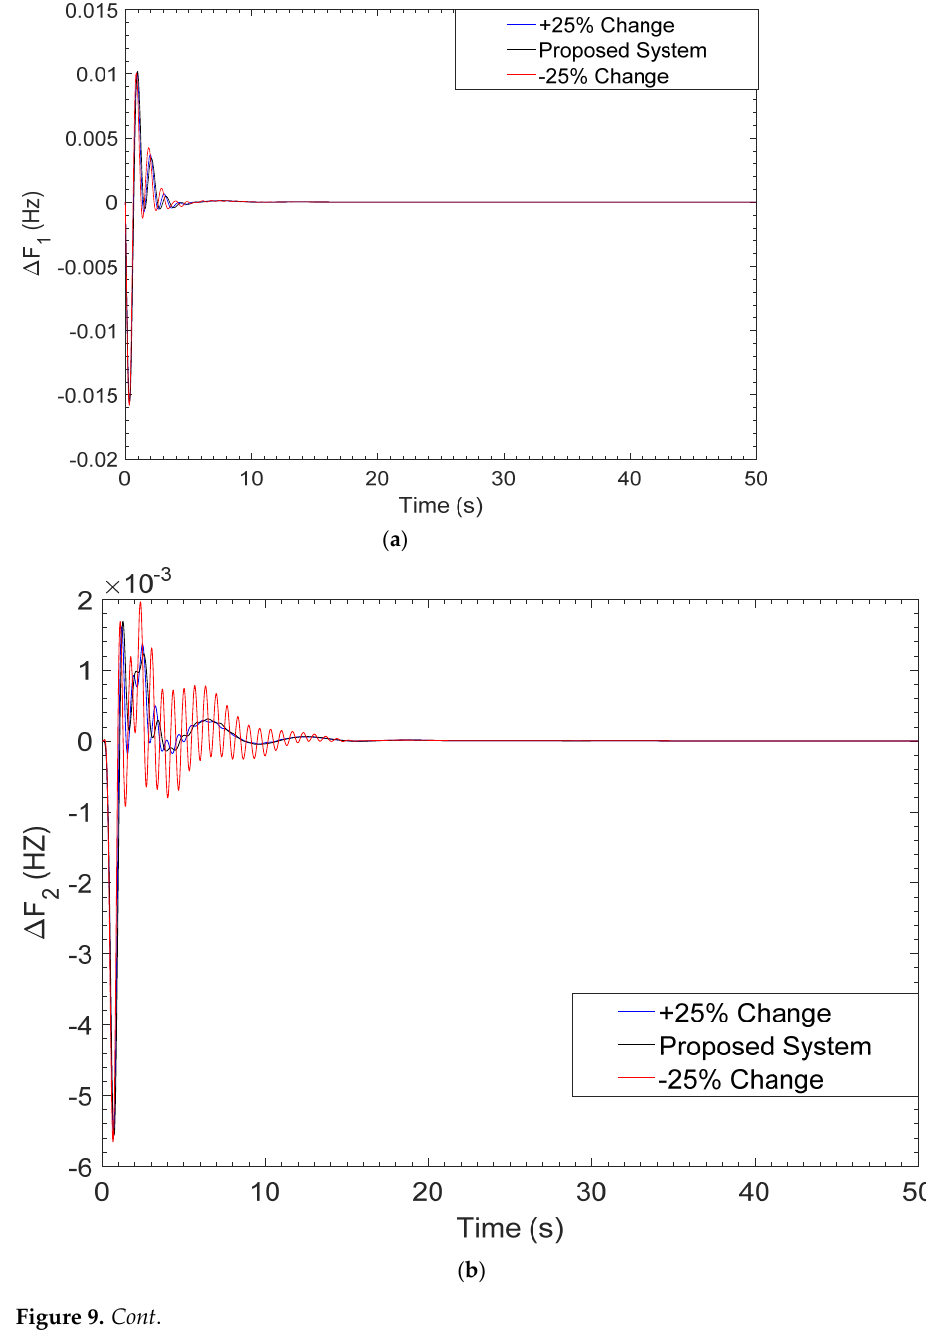
( c ) Figure 9. ( a ) Perturbation response of frequency ( Δ F 1 ) with ±25 change in T SG parameter; ( b ) pertur- bation response of frequency ( Δ F 2 ) with ±25 change in T RH parameter; ( c ) perturbation response of tie-line power ( Δ P tie ) with ±25 change in X G parameter.